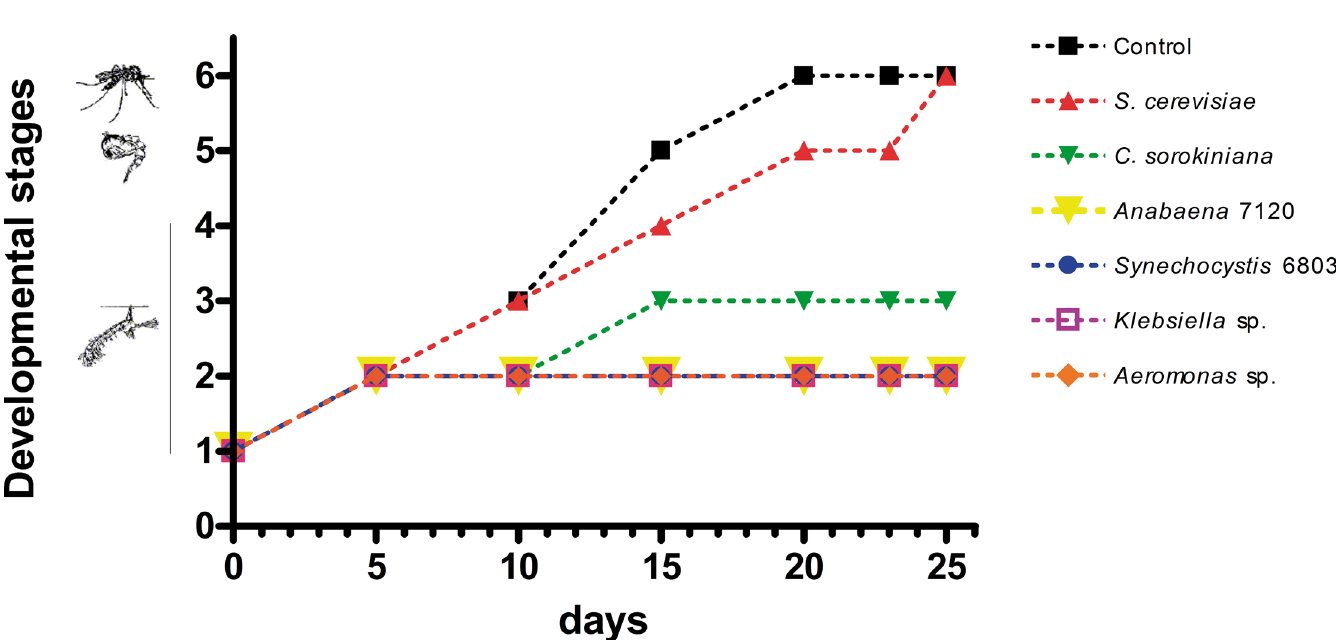
Fig 2. Developmental time of the immature stages of Cx . pipiens fed with different microorganisms. 100 larvae of Cx . pipiens were placed in groups of 20 and fed on different microorganisms ( S . cerevisiae , C . sorokiniana , Anabaena 7120, Synechocystis 6803, Klebsiella sp. and Aeromonas sp.). The larval development was observed at 5, 10, 15, 20, 23 and 25 days after feeding with each microorganism. The developmental status was determined based on the developmental state of more than 50% of individuals of each treatment.